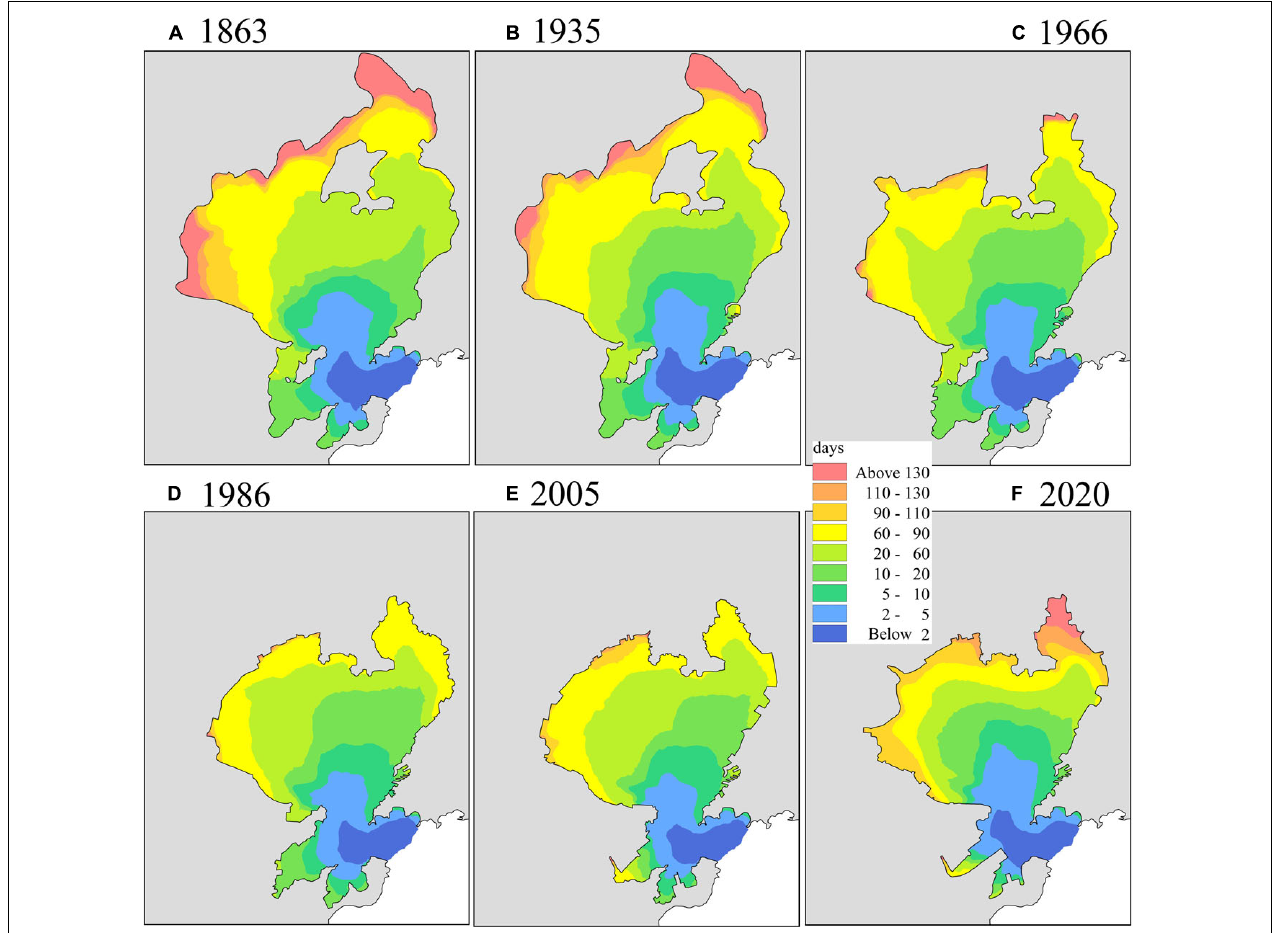
FIGURE 9 | Spatial distribution of residence time in (A) 1863 (B) 1935 (C) 1966 (D) 1986 (E) 2005 (F) 2020.